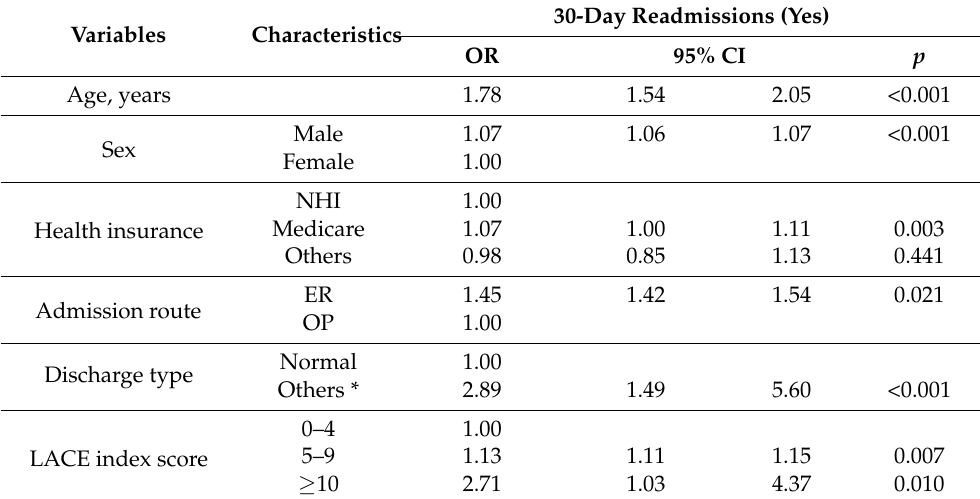
Table 3. Multivariate Logistic Regression Analysis for 30-day Readmission of Patients Hospitalized with AMI ( n =